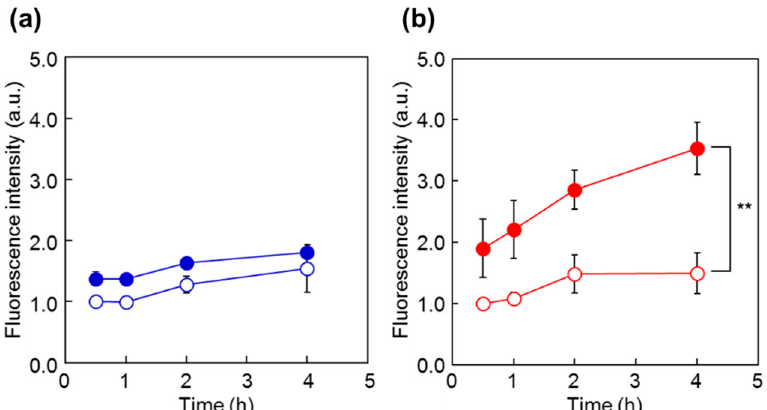
Figure 7. Fluorescence intensity of HeLa cells at various time points following incubation with polymer probes. Cells were incubated with the probes for 0.5, 1, 2, or 4 h (( a ) P(NIPAAm- co -DMAAm20%)-FL; ( b ) Tyr-P(NIPAAm- co -DMAAm20%)-FL) at either 40 °C (close circles) or 34 °C (open circles). Data are the mean ± S.D. ( n = 3) ** p < 0.01.